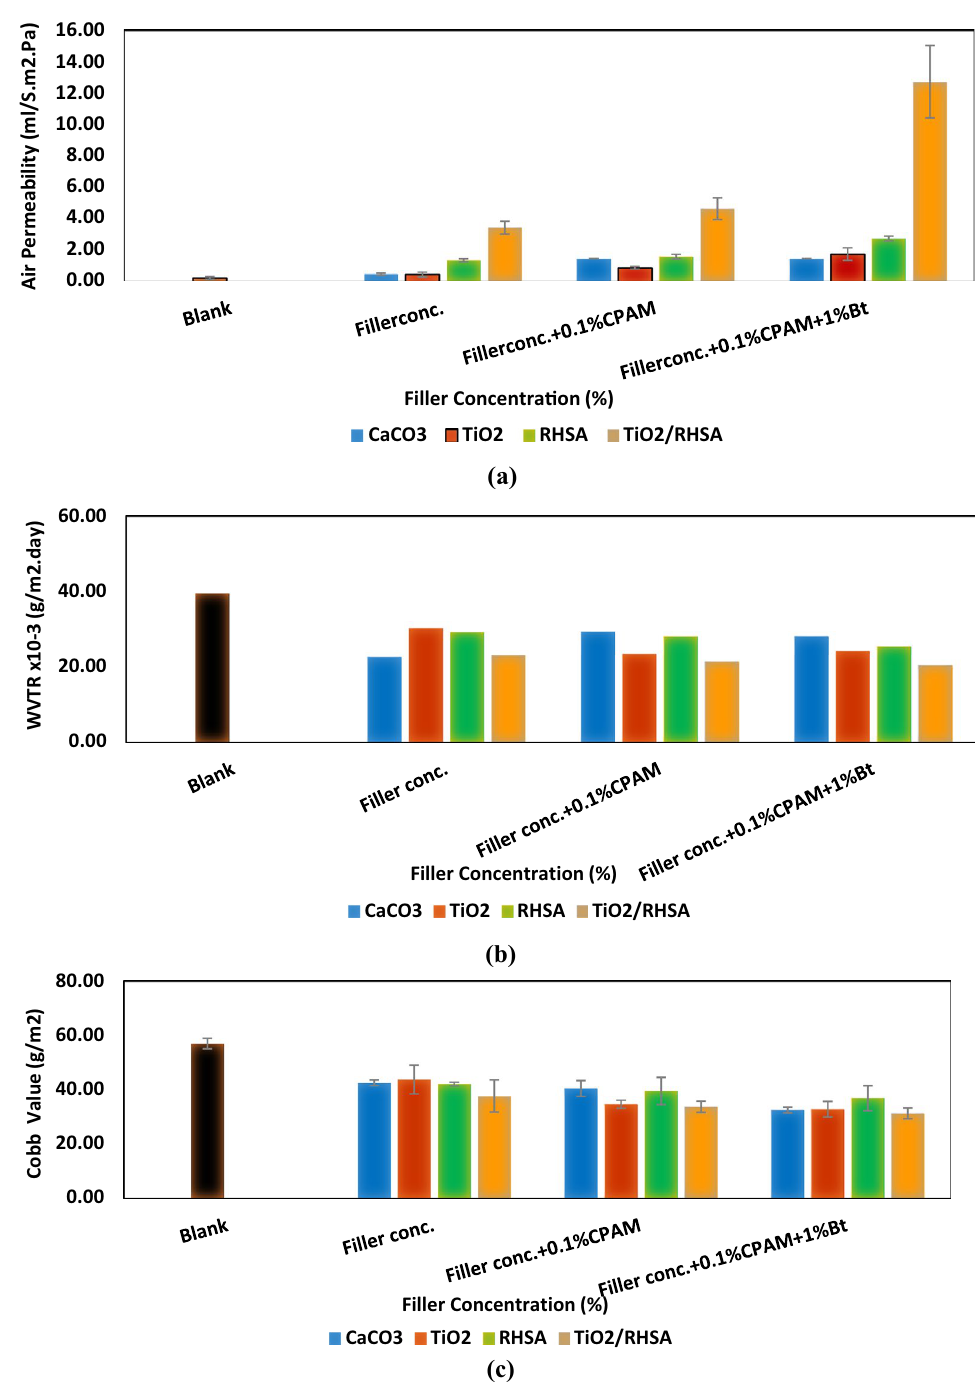
Figure 4. Barrier properties for paper sheets loaded with fillers, ( a ) air permeability, ( b ) water vapor transmittance and ( c ) cobb